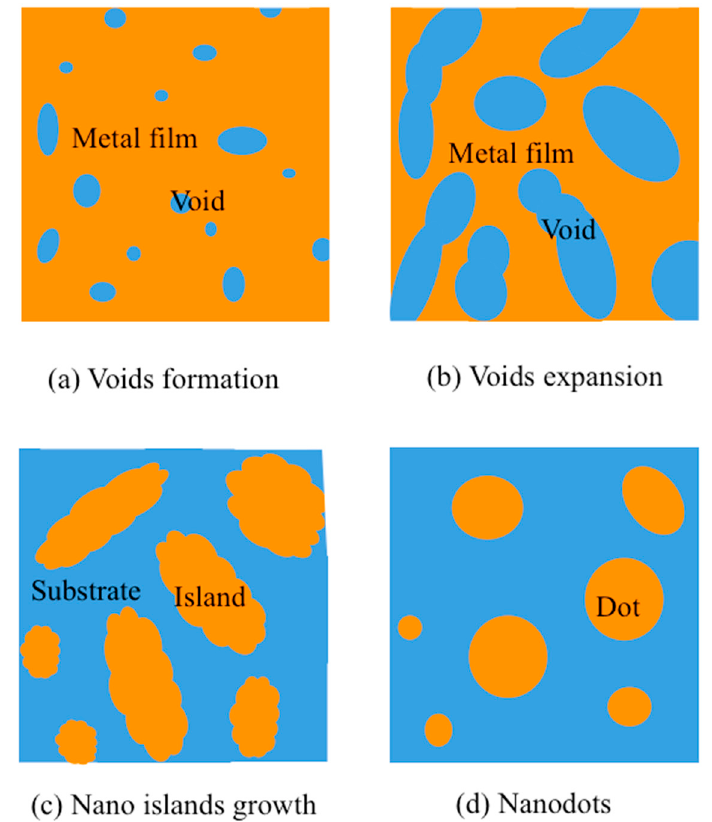
Figure 1. Thermal annealing method for a metal thin film on a substrate. ( a ) Many voids are exhibited on the metal thin film in the beginning stage. ( b ) These voids are expanded and connected to the adjacent voids. ( c ) As these voids grow, they separate the metal film into the islands. ( d ) Finally, metal particles agglomerate on a substrate.